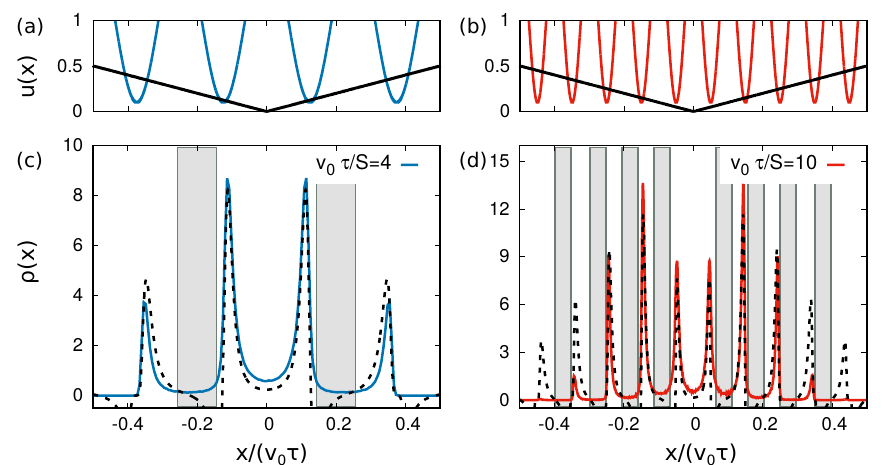
Figure 2: Density distributions. Panels (a) and (b): swim-velocity profile u ( x ) for two different values of S (colored curves), compared with the modulus of the linear force profile, | F ( x ) | = − k | x | /γ (black curve) as a reference. Panels (c) and (d): spatial density profile, ρ ( x ) , for different values of S . Solid colored lines (blue in panel (c) and red in panel (d)) are obtained by numerical simulations while dashed black lines by plotting the theoretical prediction (10) (that reduces to Eq. (16) in one dimension with Λ ( x ) given by Eq. (19)). The integral occurring in Eq. (16) has been performed numerically. Grey rectangles are drawn in the regions where Eq. (10) is not defined, say when Λ ( x ) < 0 (see the main text for more details). Panels (a), (c) and (b), (d) share the same legend. Simulations are realized in one spatial dimension with τ k /γ = 1 and α =